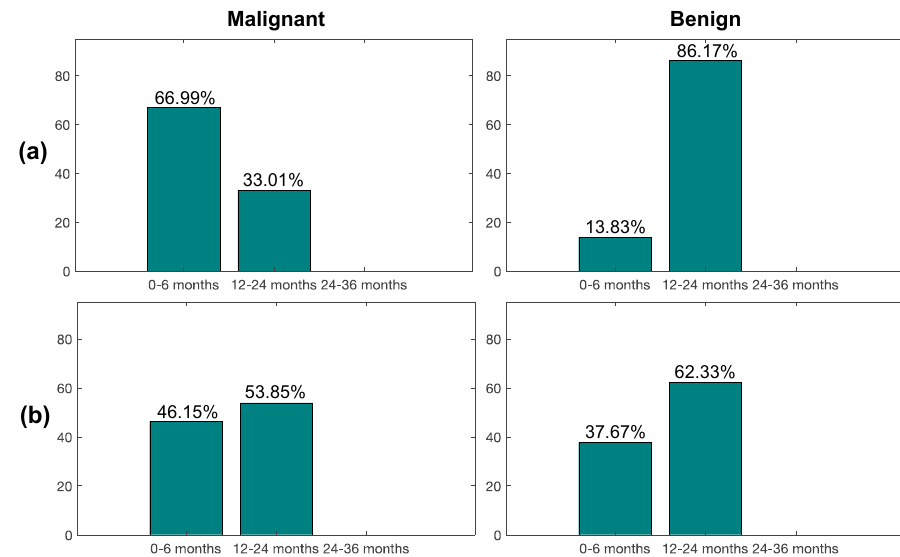
Figure 3. Percentage of LDCT second scan recalls for subjects with malignant and benign PN on the ( a ) discovery and ( b ) blinded test datasets, according to the reference standard (biopsy). Time inter- val for the second LDCT examination after LDCT baseline: (i) 0–6 months, (ii) 12–24 months, (iii) 24–36 months.